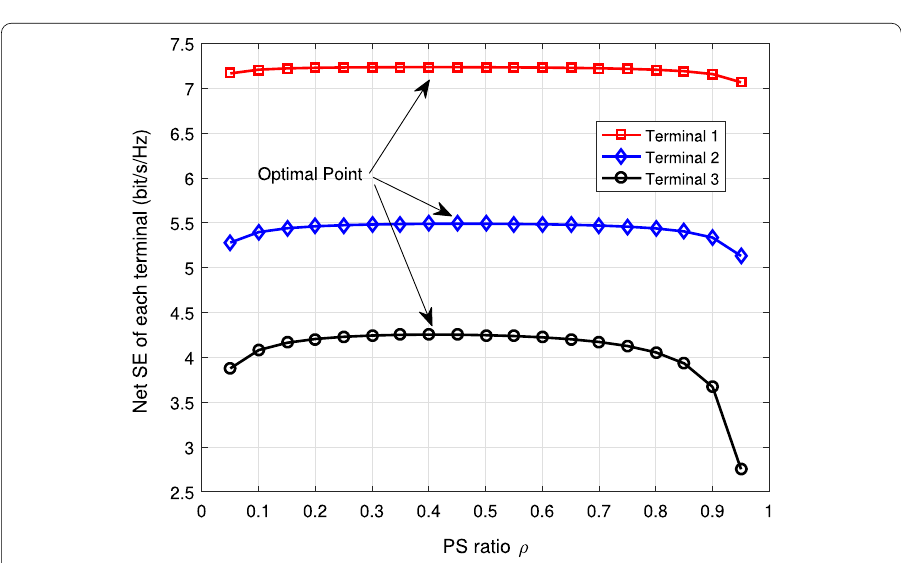
Fig. 7 Net SE of each terminal versus PS ratio, where τ = 0.015 , α = 0 , C ul min = C dl min = 0 , θ = [ 1,1,1 ] T / 3 , and (cid:31) = [ 0.5,0.5,0.5 ]